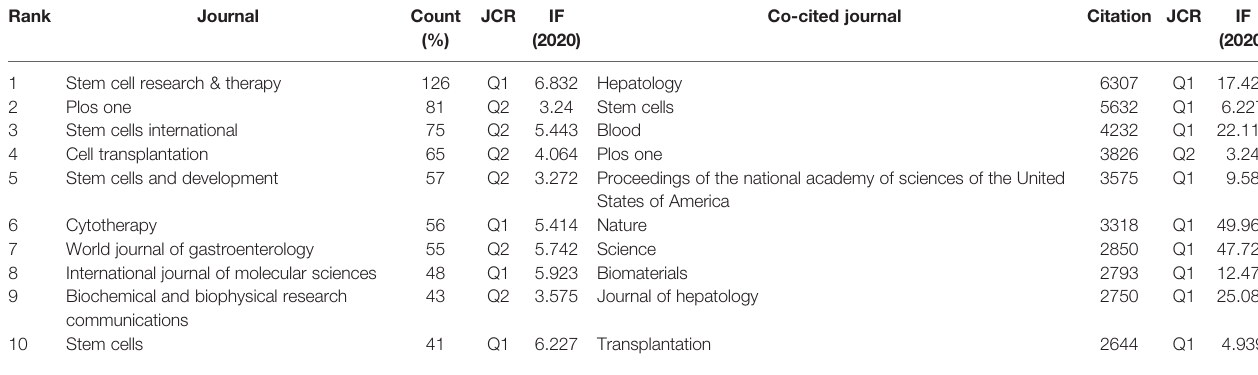
TABLE 4 | Document types of the publications.